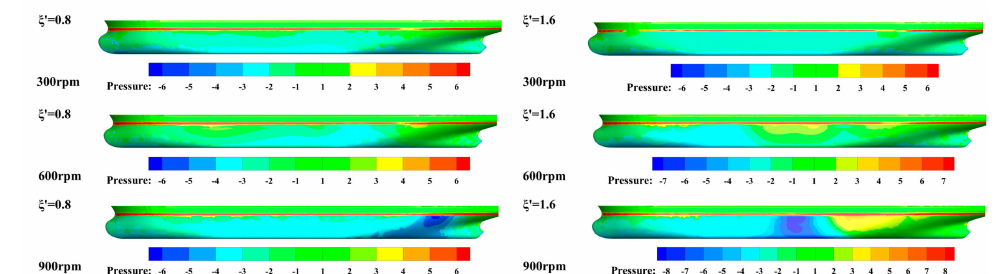
Figure 15. The dynamic pressure distribution of DS’s side surface at different propeller speed.